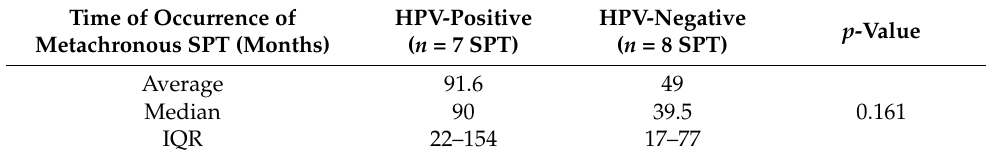
Table 5. Time of occurrence of metachronous SPT. Time of Occurrence of Metachronous SPT